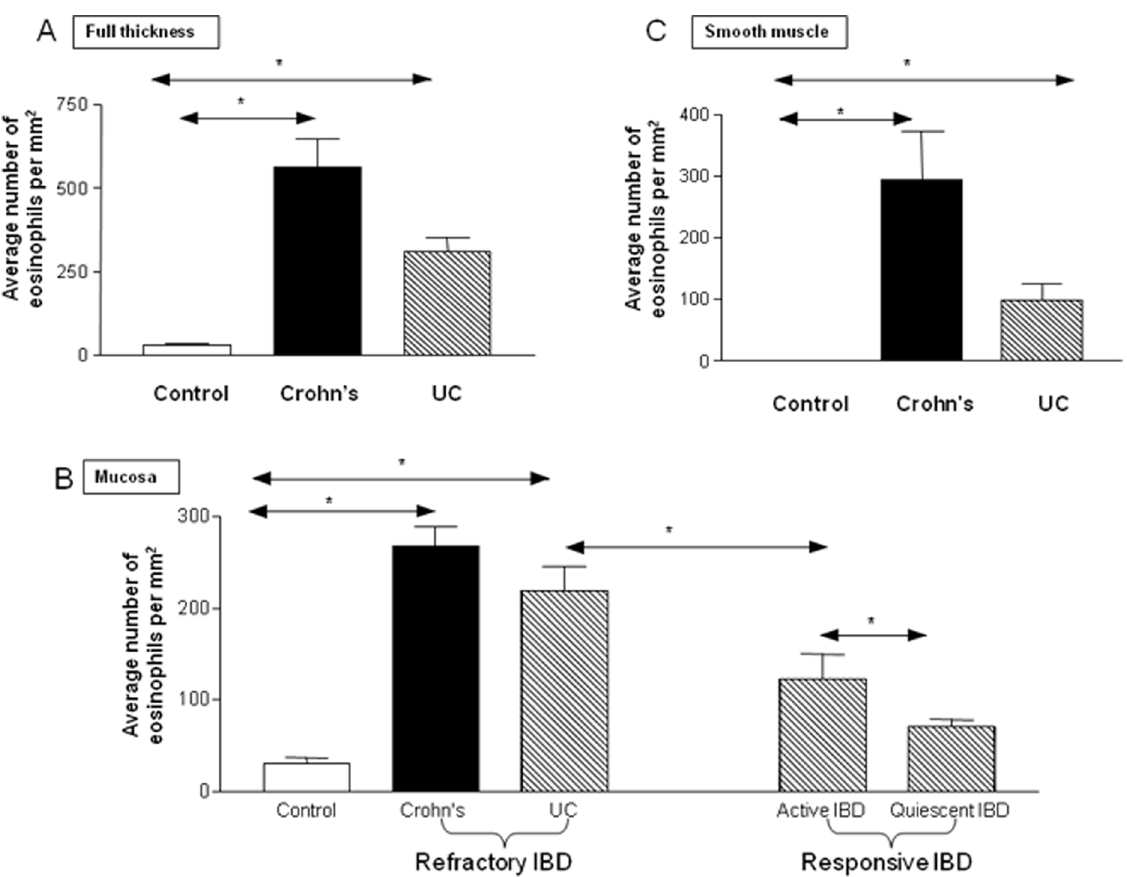
Figure 1. Quantification of Eosinophil localization to bowel wall in patients with IBD. Graph (A) shows the average number of eosinophils per mm 2 in the entire wall of the colon in patients with refractory IBD compared with controls. Graph (B) shows the average number of eosinophils per mm 2 within the mucosal layer of patients with refractory IBD and therapeutically responsive IBD compared with controls. It demonstrates that eosinophilic infiltrate correlates with disease activity in IBD. Graph (C) shows the average number of eosinophils per mm 2 within the smooth muscle layer of patients with refractory IBD compared with controls. The quantification was performed as outlined in the materials and methods section. Control patients n=8; responsive IBD n=11; refractory CD n=8; refractory UC n=7.The data are expressed as mean 6 SEM, *p , 0.05.